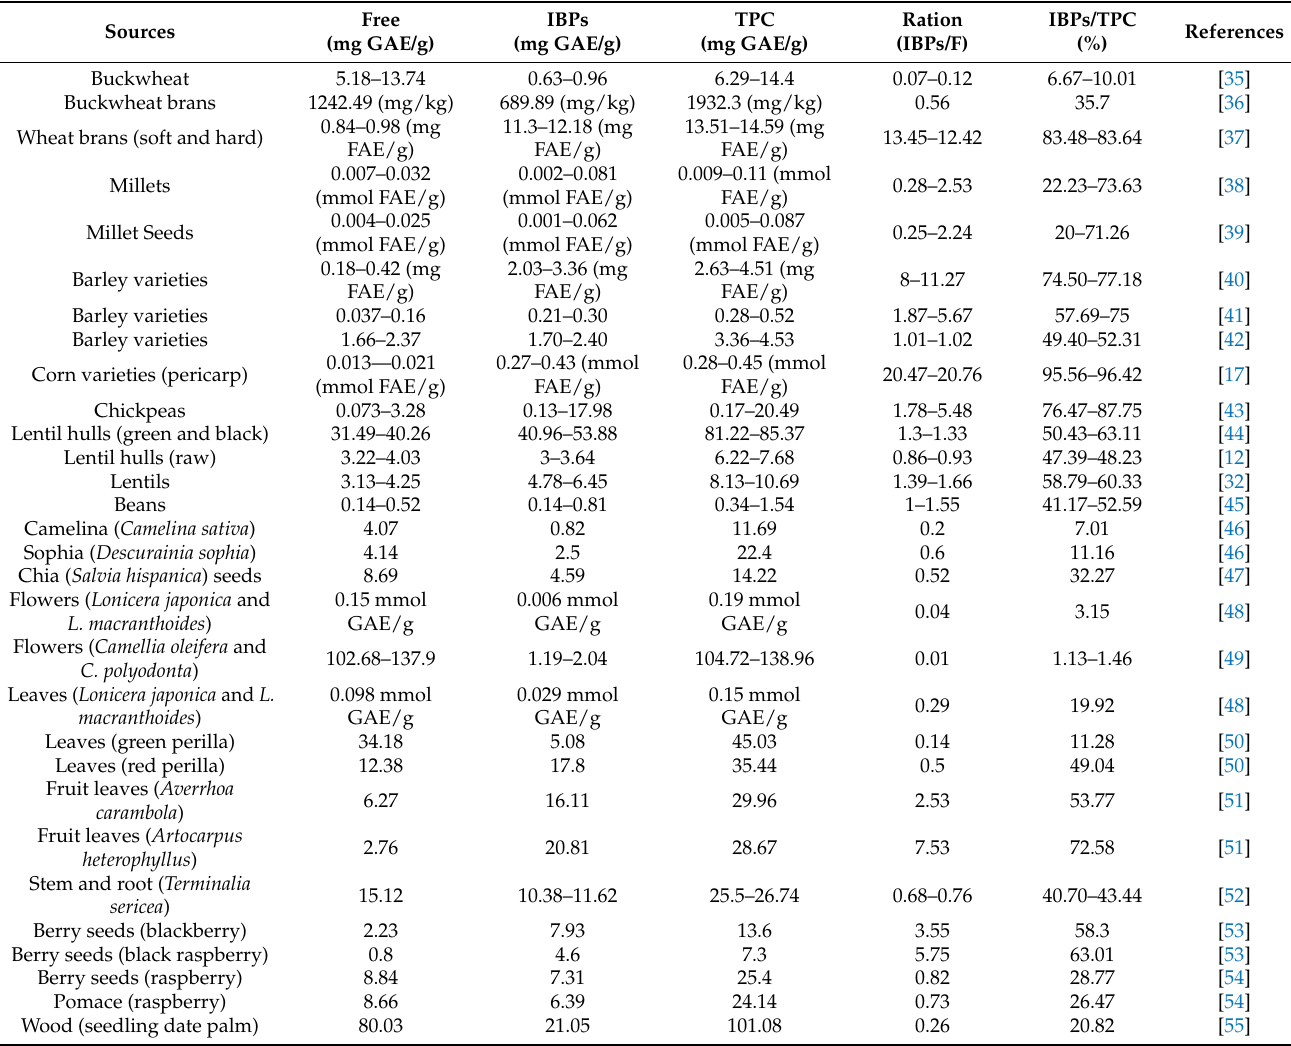
Table 2. Distribution of IBPs in various food